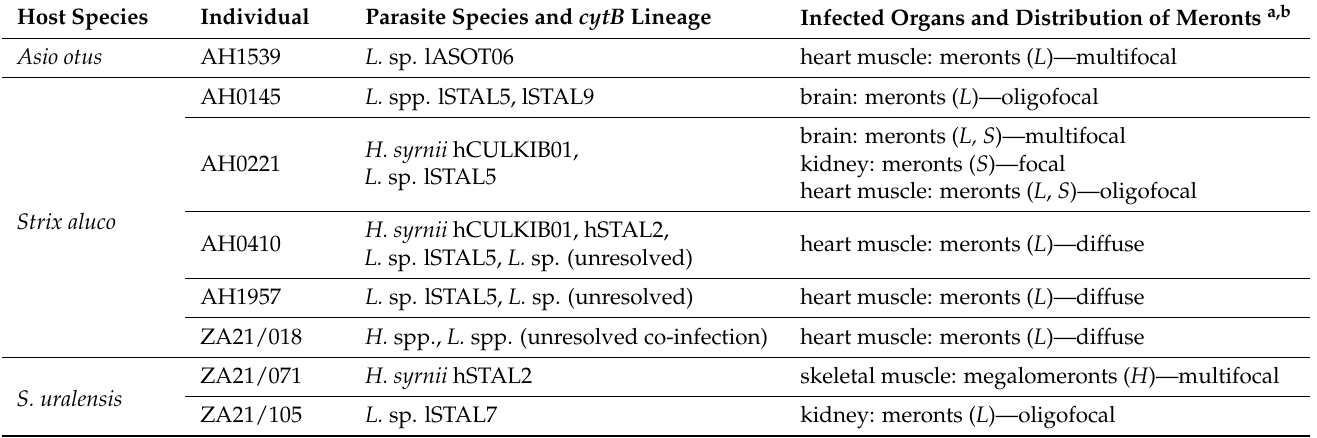
Table 2. Haemosporidian exo-erythrocytic stages detected in tissue sections of infected